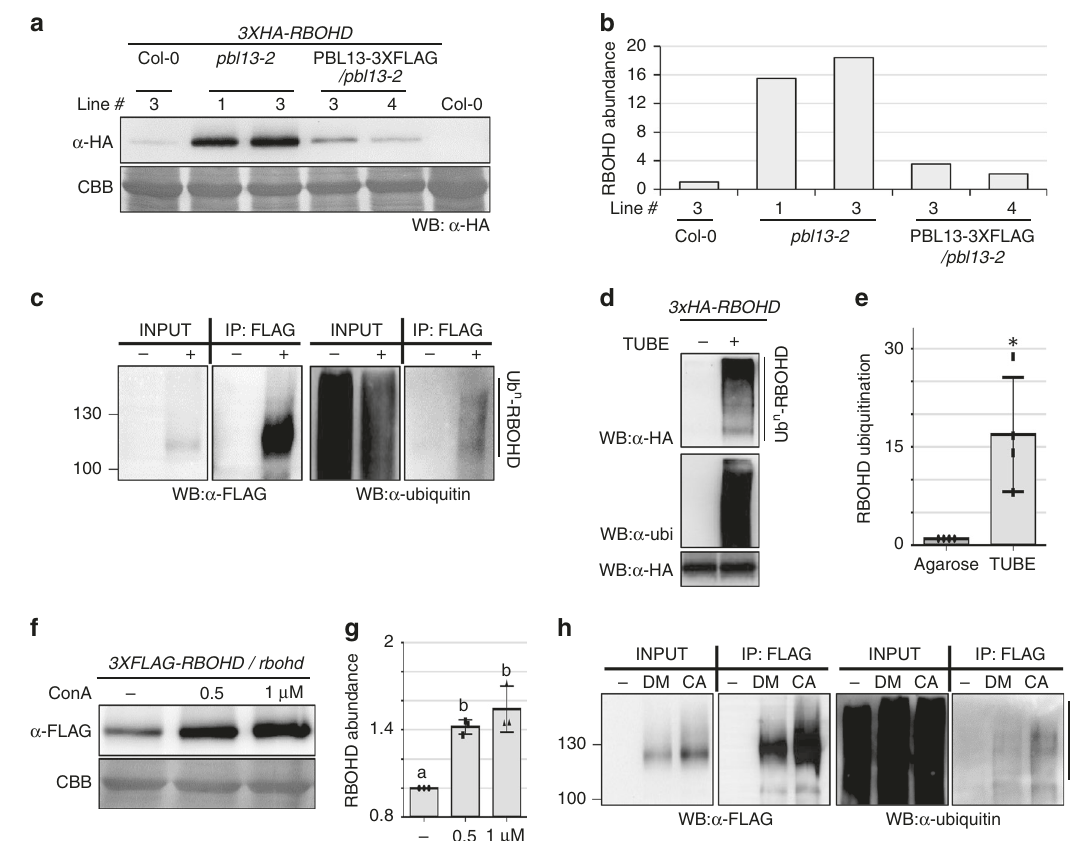
Fig. 2 RBOHD is ubiquitinated and PBL13 suppresses its accumulation. a PBL13 suppresses RBOHD protein accumulation. Arabidopsis transgenic lines expressing 3xHA-RBOHD in Col-0, plb13-2 knockout, or pbl13-2 complemented with wild type PBL13-3XFLAG were generated, and RBOHD protein levels were detected by immunoblotting with anti-HA. b Quanti fi cation of bands from blot in a , with RBOHD abundance normalized to the intensity in Col-0. Experiments were repeated three times. c RBOHD is polyubiquitinated in vivo. Col-0 ( − ) or transgenic Arabidopsis lines expressing 3xFLAG-RBOHD ( + ) were used for immunoprecipitation with FLAG antibody. Polyubiquitination was detected by laddering after immunoblotting with ubiquitin antibody. d Ubiquitination of RBOHD is detected by Tandem Ubiquitin Binding Entity (TUBE). Ubiquitinated proteins were puri fi ed using agarose resin conjugated with TUBE ( + ) from microsomal fractions expressing 3xHA-RBOHD in N. benthamiana . Agarose resin ( − ) was used as a control. Ubiquitinated RBOHD (top panel) and input of RBOHD (bottom panel) were detected by immunoblotting with anti-HA. Immunoblotting using anti-ubiquitin (middle panel) shows speci fi city of the TUBE assay to purify ubiquitinated proteins. e Quanti fi cation of ubiquitination based on the TUBE assay. After incubation with agarose or TUBE, lanes from the HA immunoblot were quanti fi ed in Image Lab, and samples were normalized to the intensity of the agarose control. Statistical differences were determined by Student ’ s t-test , α = 0.05, n = 4 blots ± SD and asterisk (*) indicates signi fi cant differences. f RBOHD is subjected to vacuolar-mediated degradation. Transgenic lines expressing 3xFLAG-RBOHD treated with Concanamycin A (ConA) but not DMSO ( − ) exhibited enhanced accumulation of RBOHD. RBOHD protein was detected by immunoblot with anti-FLAG. g Quanti fi cation of the blot shown in f , with RBOHD abundance normalized to the intensity after DMSO treatment. Statistical differences were determined by ANOVA with post-hoc Tukey HSD test, α = 0.05, n = 3 ± SD and letters indicate signi fi cant differences. h Inhibition of vacuolar degradation leads to enhanced accumulation of RBOHD and ubiquitinated RBOHD. Col-0 ( − ) and transgenic 3xFLAG-RBOHD lines were treated with Concanamycin A (CA) or DMSO (DM), followed by anti-FLAG